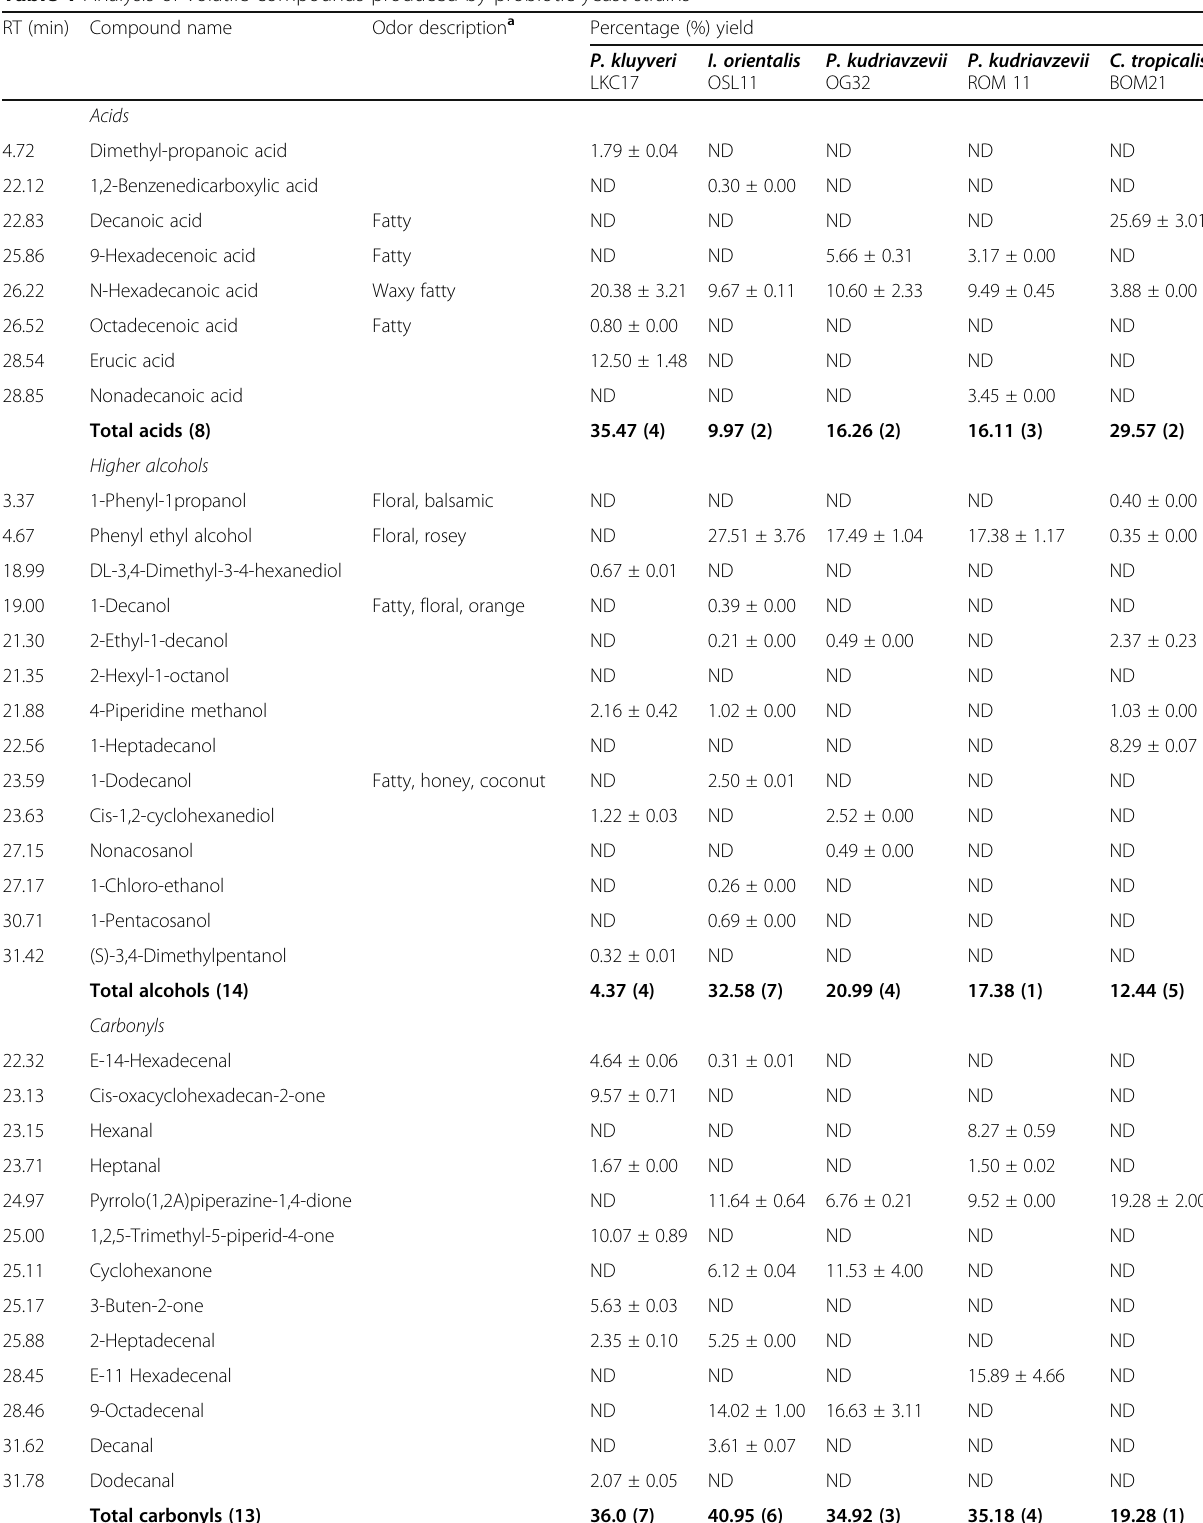
Table 1 Analysis of volatile compounds produced by probiotic yeast